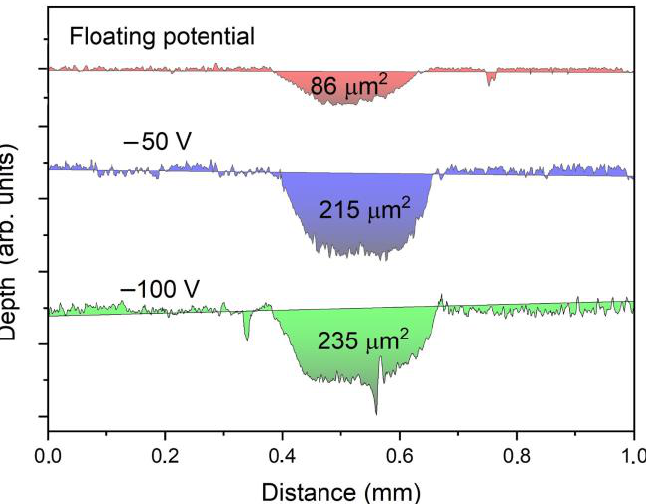
Figure 6. Wear track profiles of the TiAlN coatings deposited by the Al magnetron at 30 W of power and different substrate bias voltages.